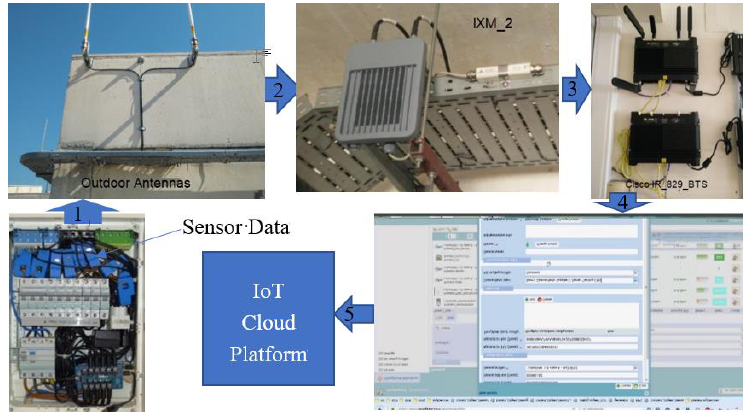
Figure 2. Components of the implemented Cisco LoRa communication solution: Local equipment performs sensor data acquisition and LoRa transmission. An outdoor antenna receives (1) the LoRa signal and directs it (2) to the IXM_2 (antenna and IXM_2 perform the function of the LoRa gateway identified on Figure 1). IP communication is performed (3) from the IXM_2 to Cisco